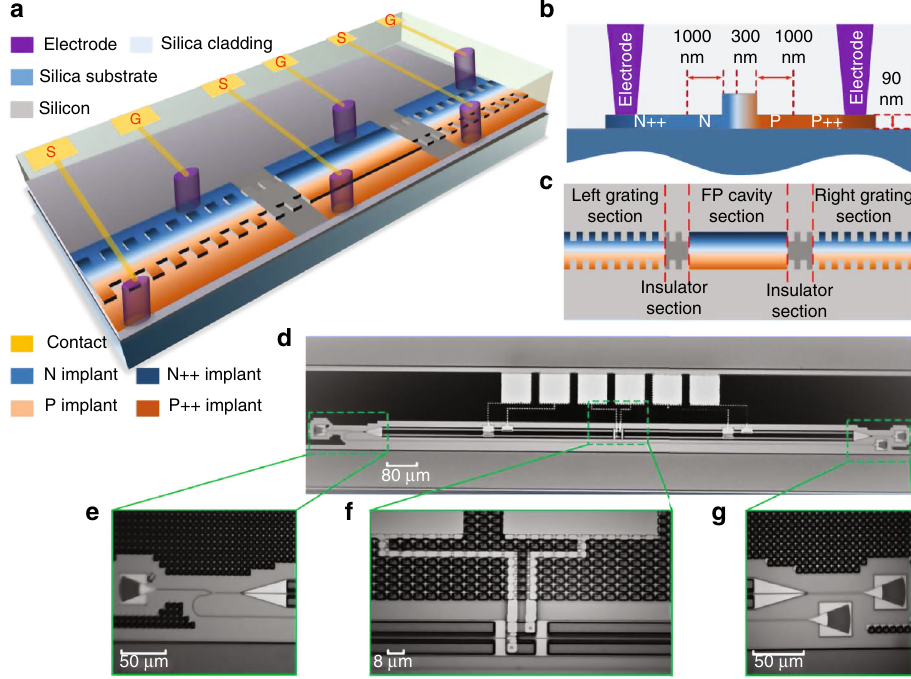
Fig. 2 The designed recon fi gurable grating. a Perspective view of the grating on a silicon chip. b Cross-sectional view of the grating rib waveguide. c Top- view of the grating. d - g Microscope camera images of the fabricated grating, the input grating coupler and compact Y-branch, the FP cavity section, and the transmission and re fl ection grating